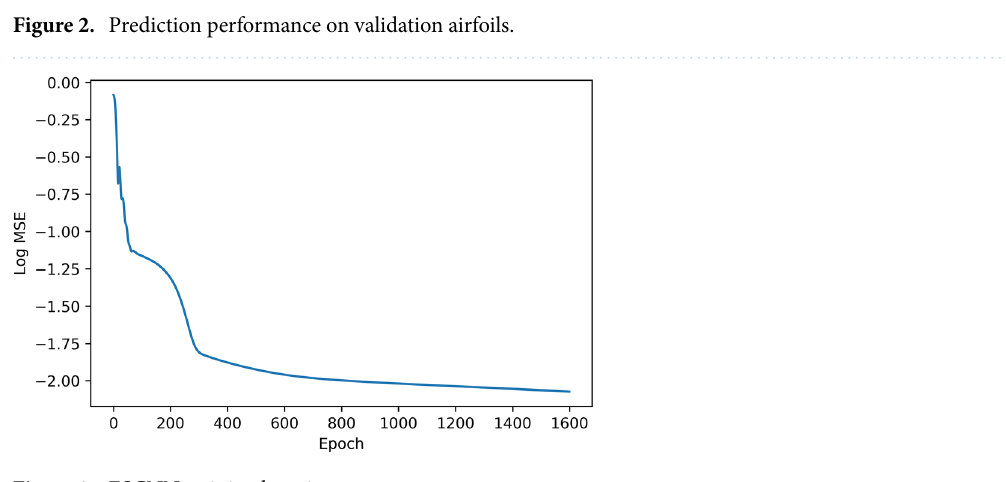
Figure 3. ESCNN training learning